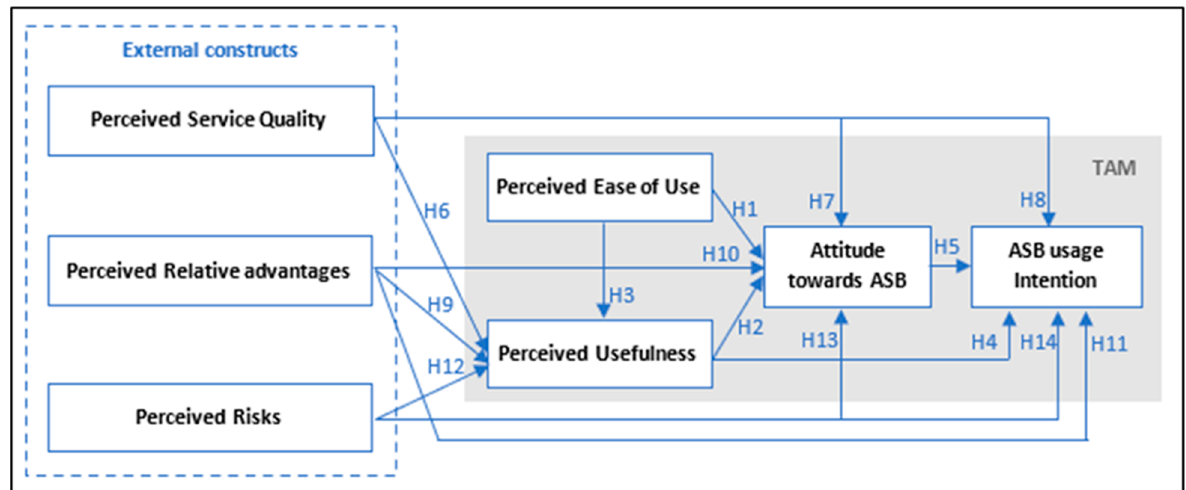
Figure 2. The conceptual research model for the ASB acceptance investigation.